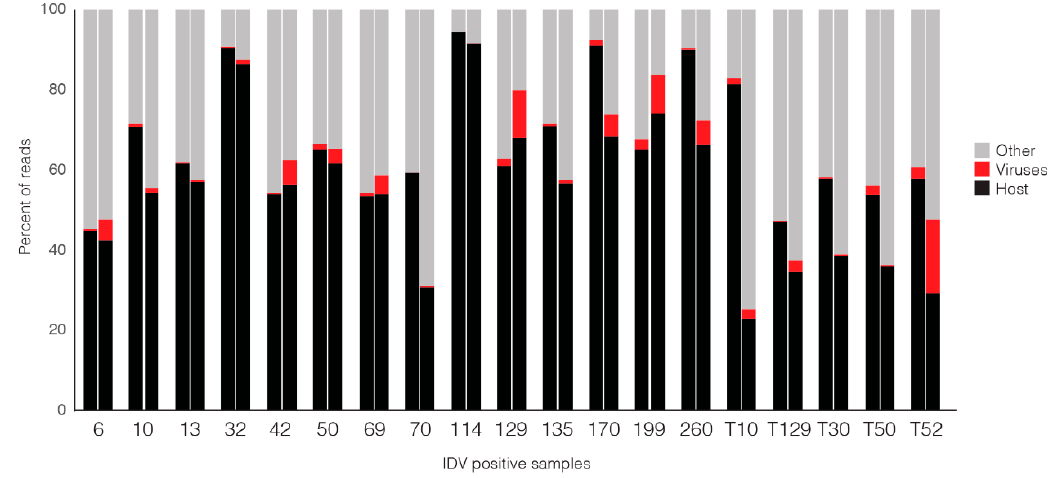
Figure 3. Proportions of reads corresponding to host, viruses or other taxa (bacteria, fungi, unclassified) from 19 IDV-positive samples sequenced using Nanopore sequencing (WIMP) (left bar in each pair) and MiSeq sequencing (right bar). Labels on the x -axis indicate individual specimens; tracheal samples are denoted by “T” before animal number.